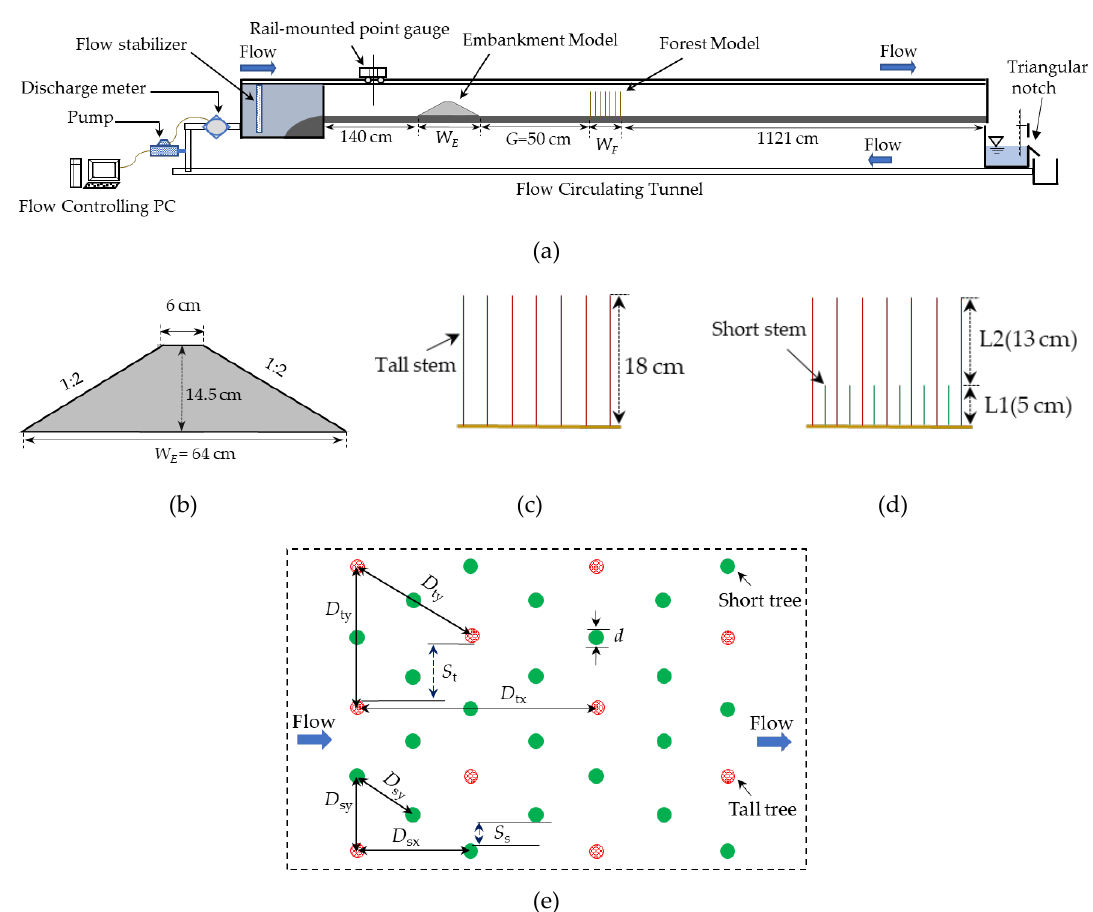
Figure 1. Schematic of the experimental setup: ( a ) Side view of the experimental flume with embankment and forest model, ( b ) embankment model (EM), ( c ) side view of single layer model (SLM), ( d ) double-layer model (DLM), and ( e ) plan view of double-layer (DLM) forest arrangement (please see Section 2.1.2 for the meaning of the symbols; W F = 24.27 cm).